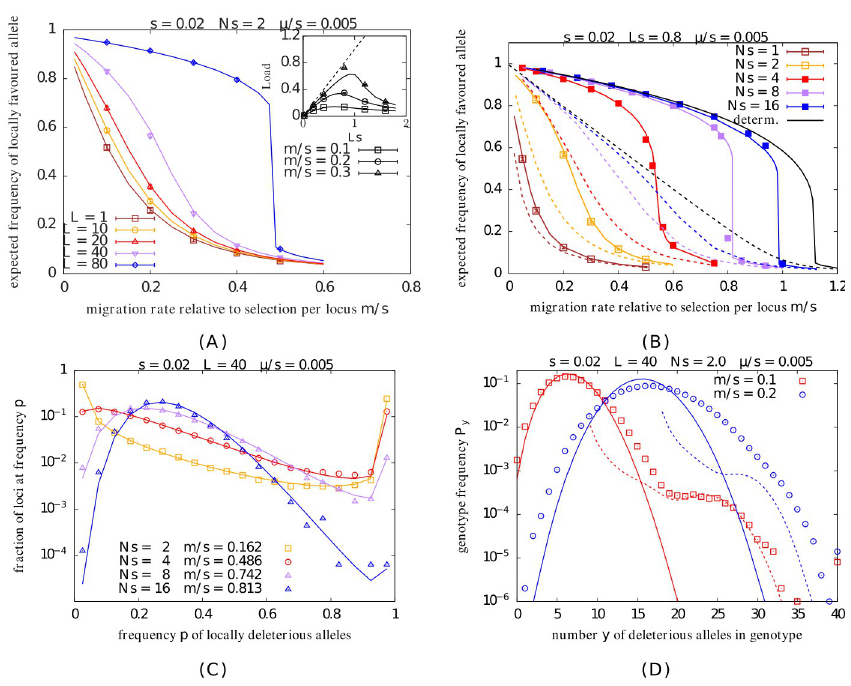
Fig 1. Local adaptation under mainland-island migration. A. Expected frequency 1 (cid:0) E ½ p � of the locally favoured allele on the island vs. m / s , the migration rate relative to selection per locus, for various L (different colors) for s =0.02, Ns =2, and μ / s =0.005. Inset: Expected load vs. Ls (which is varied by changing L ) for various values of m / s . The maximum possible load Ls (dashed line) is also shown for reference. B. Expected frequency of the locally favoured allele vs. m / s for various Ns (different colors) for s =0.02, L =40 and μ / s =0.005.Symbols depict results of individual- based simulations in both Fig 1A and 1B (obtained by averaging over 100–200 simulation replicates for each point). Colored solid lines show theoretical predictions that account for both LD and drift (obtained from Eq (7) together with Eq (4)); colored dashed lines in 1B show LE/single-locus predictions that only account for drift (and are obtained from Eq (1)). Fig 1B also shows deterministic predictions that account for LD (solid black line) as well as the LE/single-locus deterministic prediction (dashed black line). See main text for how these are calculated. Note that there are no simulation results for the deterministic case (as individual-based simulations are always affected by drift). C. Distribution of allele frequencies shown by plotting the fraction of loci with frequency of locally deleterious allele between p and p + Δ p , vs. p (for Δ p =0.05). The different colors show distributions for N =100, 200, 400, 800 (which correspond to Ns =2, 4, 8, 16, for s =0.02), with m / s chosen in each case such that the expected frequency of the locally deleterious allele is 0.3. Theoretical allele frequency distributions (lines) match well with those from individual-based simulations (symbols), with some (moderate) deviation in larger populations. Theoretical predictions are obtained using Eq (1) with m replaced by m , which depends on E ½ p � , which is determined numerically, as above. D. Genotype e frequencies P , which represent the probability that a randomly chosen genotype in the population carries y deleterious y alleles, vs. y , for two different values of m / s , for Ns =2 and s =0.02. Symbols depict results of individual-based simulations; dashed lines show deterministic predictions and solid lines predictions under LE (see text for more details about the two kinds of predictions). Other parameters for C. and D. are: L =40 and μ / s